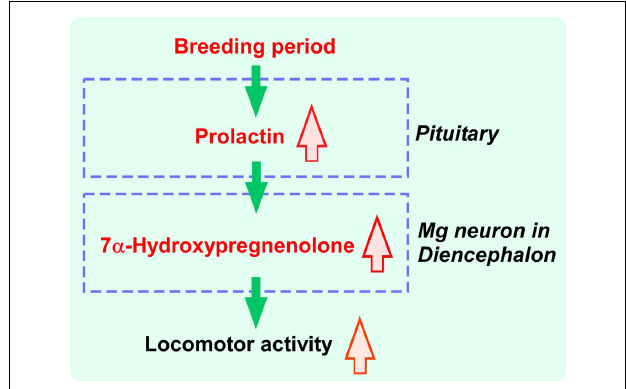
FIGURE 4 | Schematic model depicting the action of PRL on the regulation of seasonal changes in 7 α -hydroxypregnenolone synthesis and locomotor activity in newts. PRL synthesized in the adenohypophysis, by acting on Mg neurons in the hypothalamus, induces the expression of cytochrome P450 7 α . Cytochrome P450 7 α and PRL receptor (PRLR) are colocalized in Mg neurons.Thus, prolactin, an adenohypophyseal hormone, regulates 7 α -hydroxypregnenolone synthesis in the brain, and also induces seasonal locomotor changes. See the text for